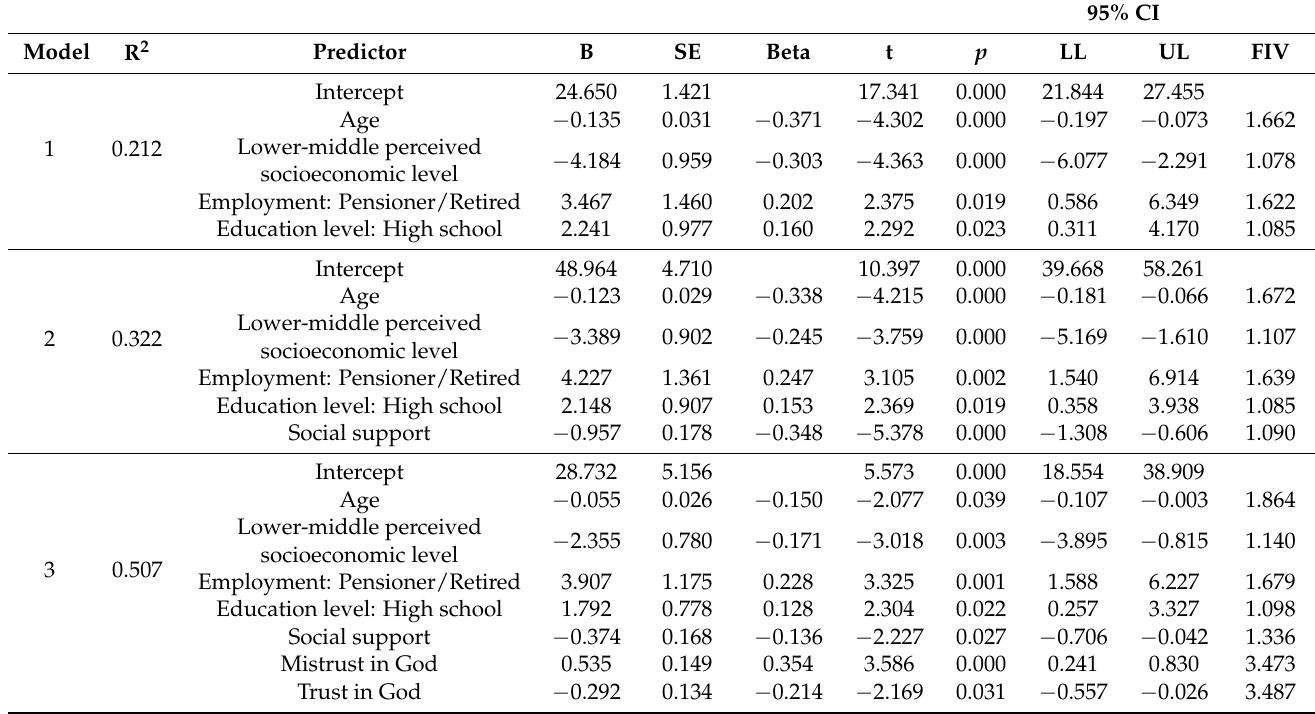
Table 4. Predictive models of PANAS negative